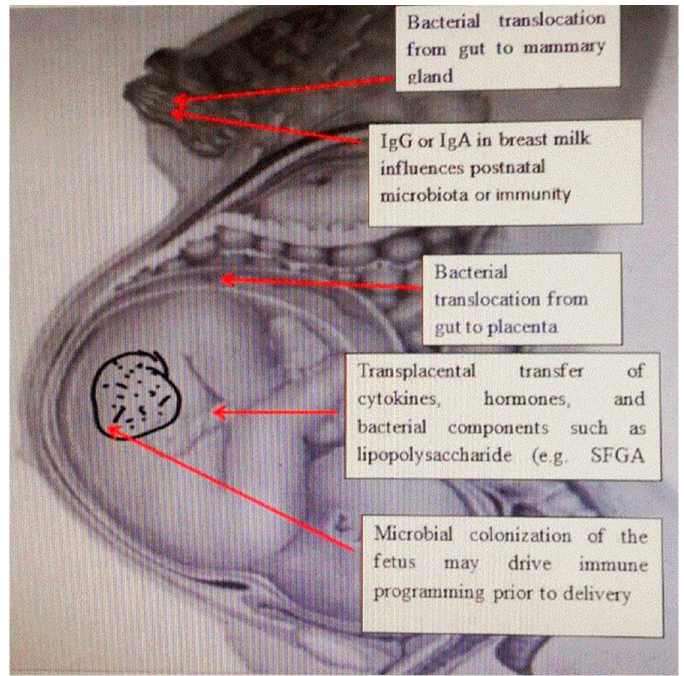
Figure 1. The relationship between maternal microbiota and newborn immunity. Commensal microbes from the intestine of the pregnant woman, and the placenta and mammary glands affect the development of immunity in the fetus and the newborn by releasing short-chain fatty acids, and antibodies and changing the cytokine environment.